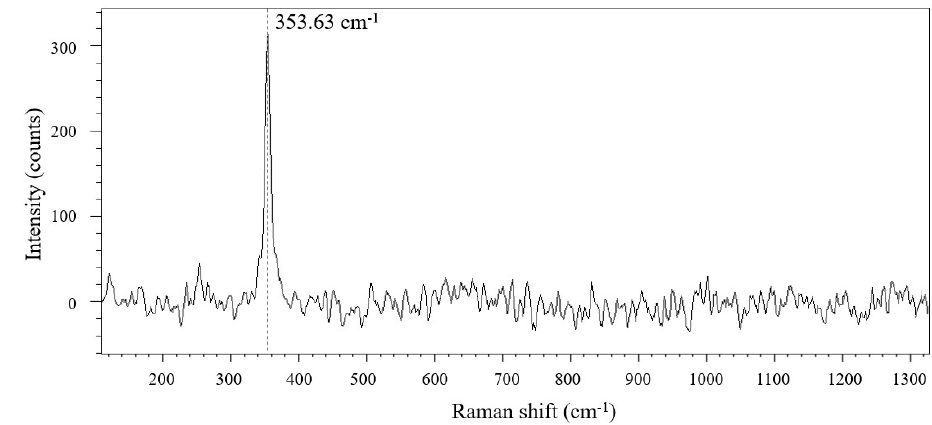
Figure 6. XRD spectra of a cementitious matrix with different CBN contents at 28 days.